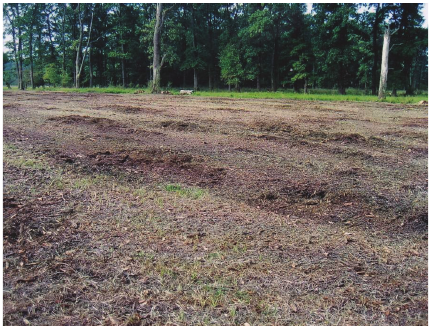
Figure 8: Site prepared for artificial regeneration.